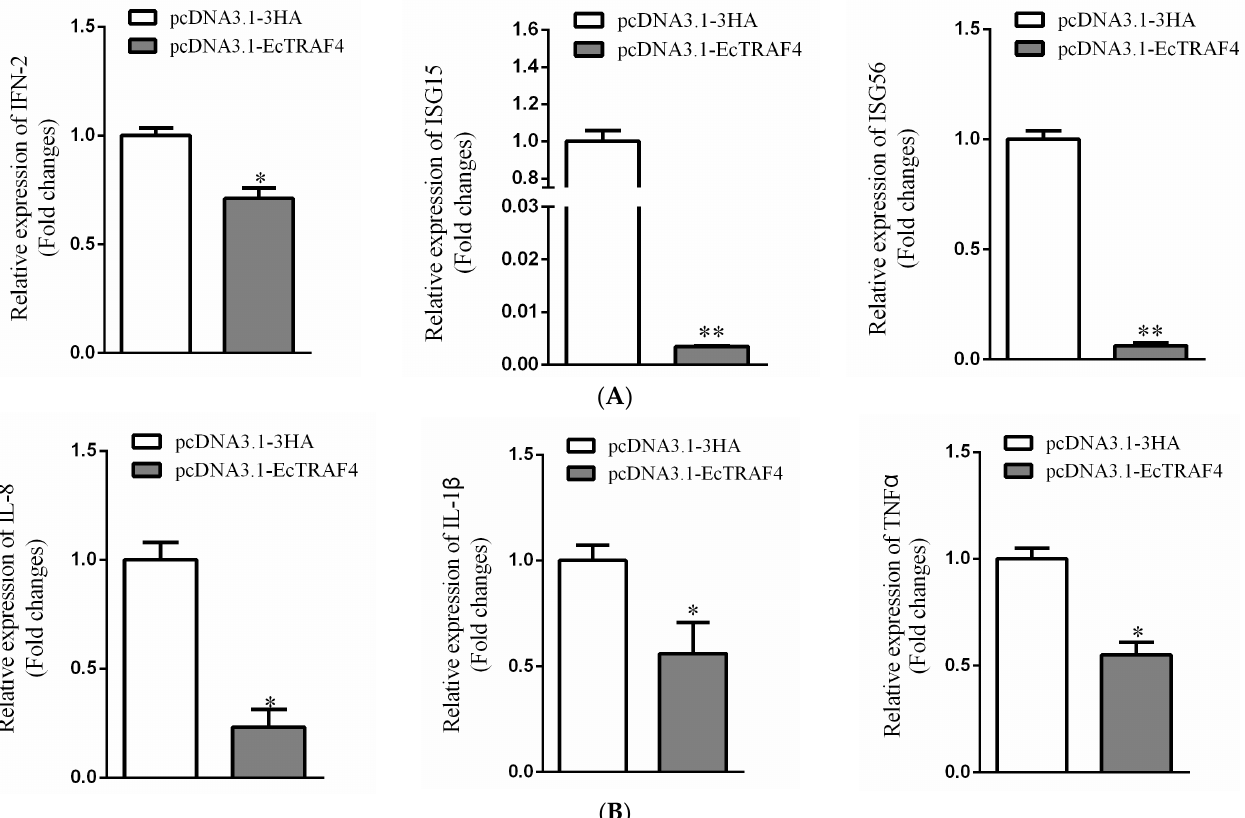
Figure 10. Relative expression levels of IFN-signaling molecules and proinflammatory cytokines in EcTRAF4-overexpressing cells. ( A ) Expression changes of IFN-signaling molecules (ISG15, ISG56 and IFN-2) in EcTRAF4-overexpressing cells (means ± S.E., n = 3). ( B ) Expression changes of inflammatory factors (IL-1 β and TNF α ) in EcTRAF4-overexpressing cells (means ± S.E., n = 3). β -actin was used as the internal control. The asterisk denotes a significant difference (* p < 0.05 and ** p < 0.01).